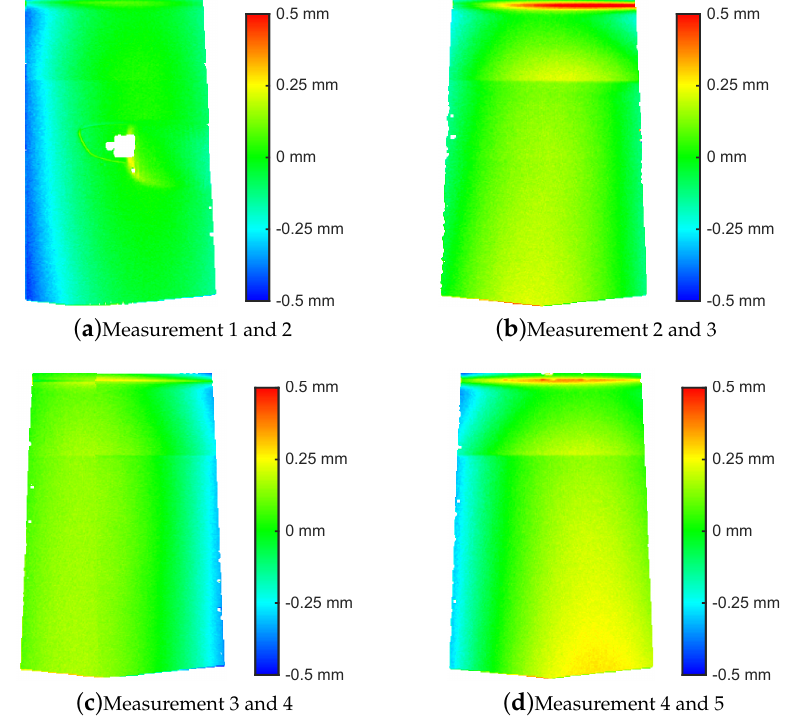
Figure 9. Point-to-plane distance (colour-coded) on overlap region of registered point clouds. Measurements 1, 2 and 3 correspond to the 3D data shown in Figure